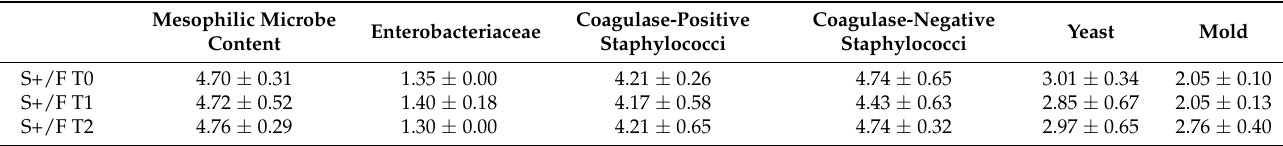
Table 7. Effect of post dry aging on microbiological profile measured as Log (CFU/g) of buffalo meat fed ray grass and bred at low density (S+/F) in Longissimus muscle at T0, 30 days (T1), and 60 days (T2) after maturation. Mesophilic Microbe Content